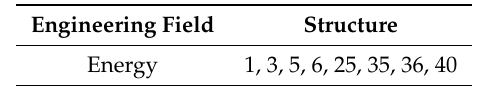
Table 1. Invention principle solutions given by the BioTRIZ conflict matrix.